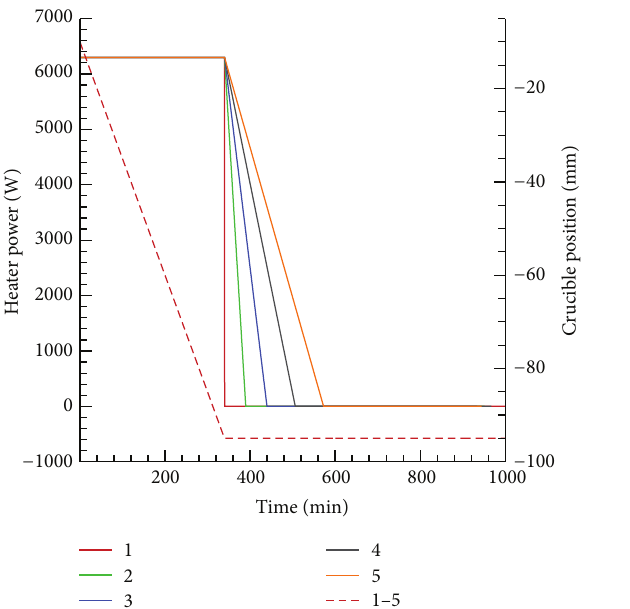
Figure 3: Analysis conditions for heater power (solid lines) and crucible positions (dashed lines).